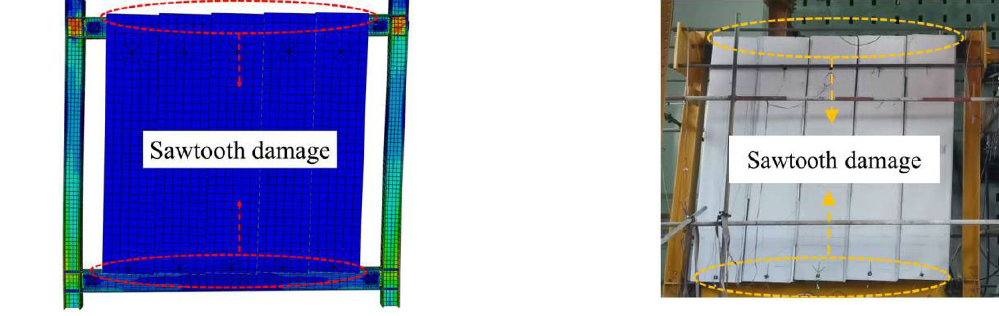
Figure 18. Comparison of results by finite element analysis and test. ( a ) Comparison of failure modes of ALC panels. ( b ) Comparison of the slipping of connecting bolts.